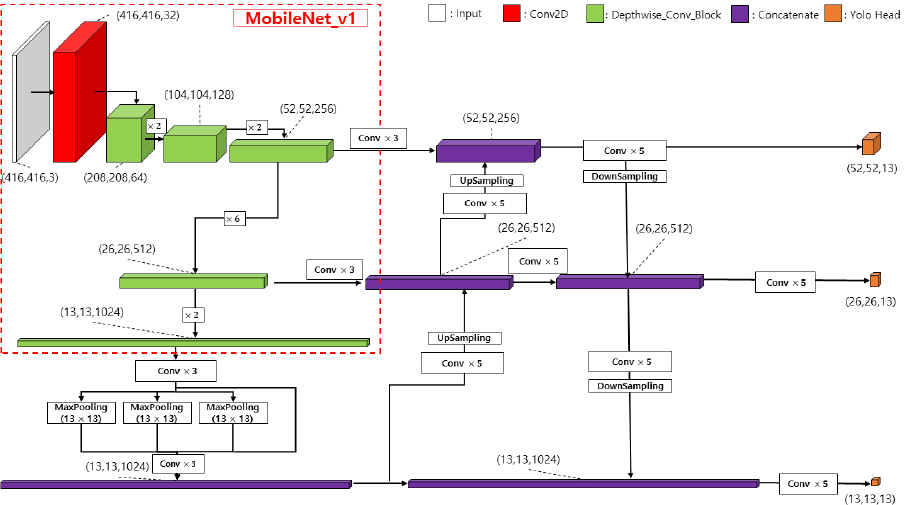
Figure 6. MobileNetv1 replaces the original YOLOv4 backbone network.